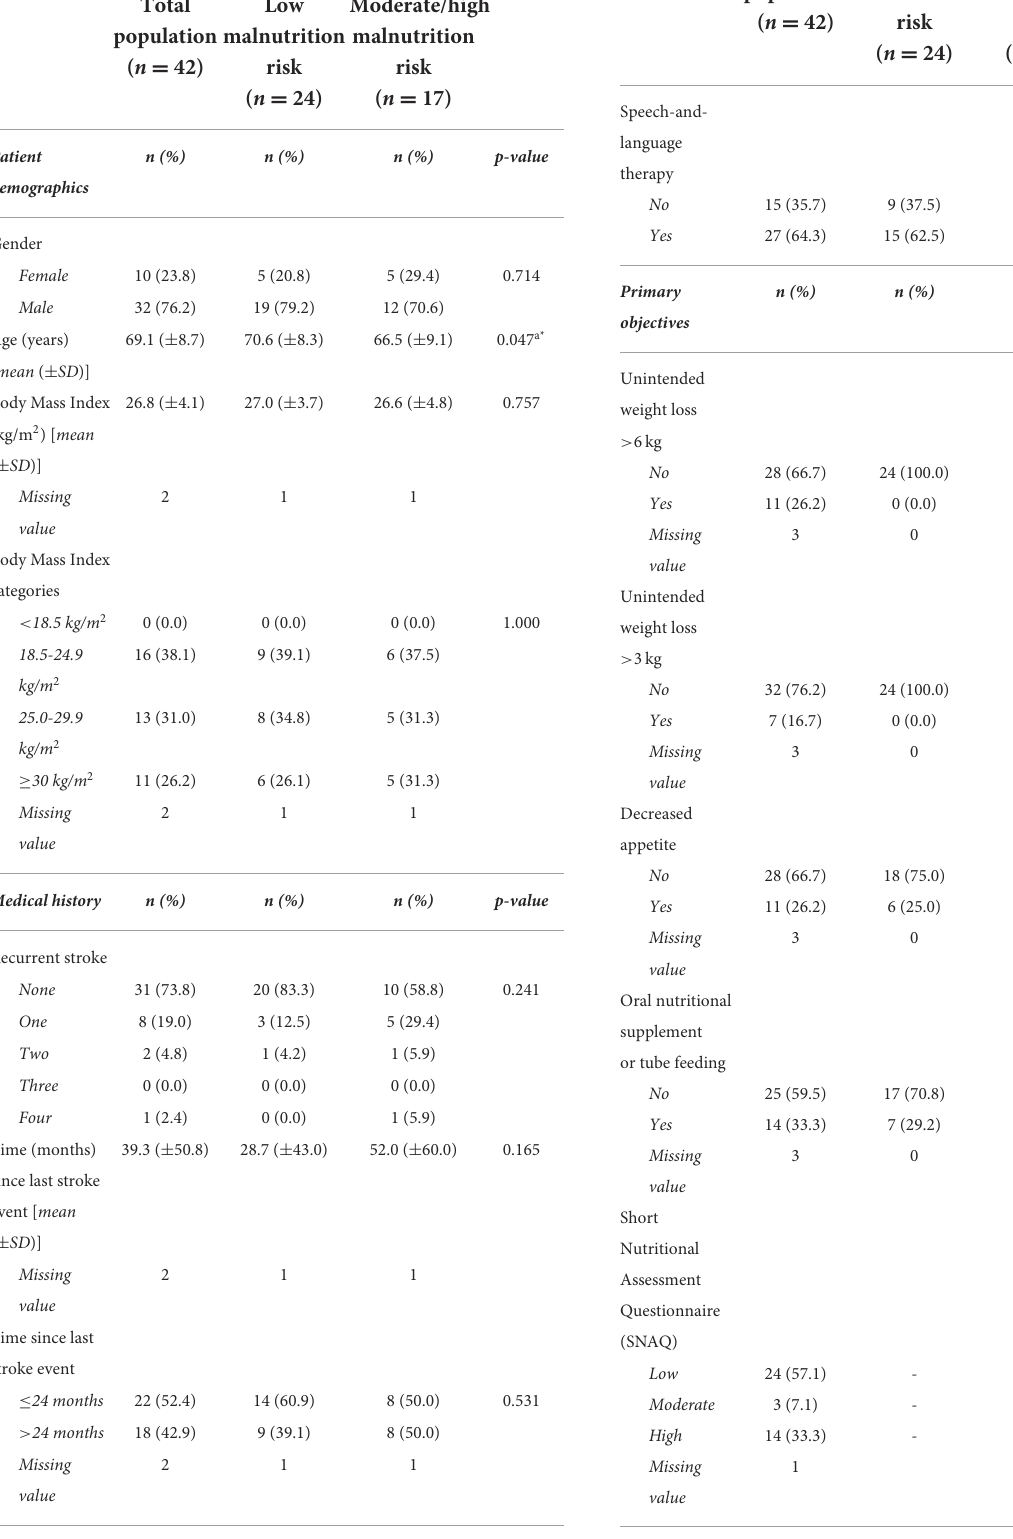
TABLE 1 Patient characteristics of the total population ( n = 42) and in patients with low risk of malnutrition vs. moderate or high risk of malnutrition according to the SNAQ ( n =